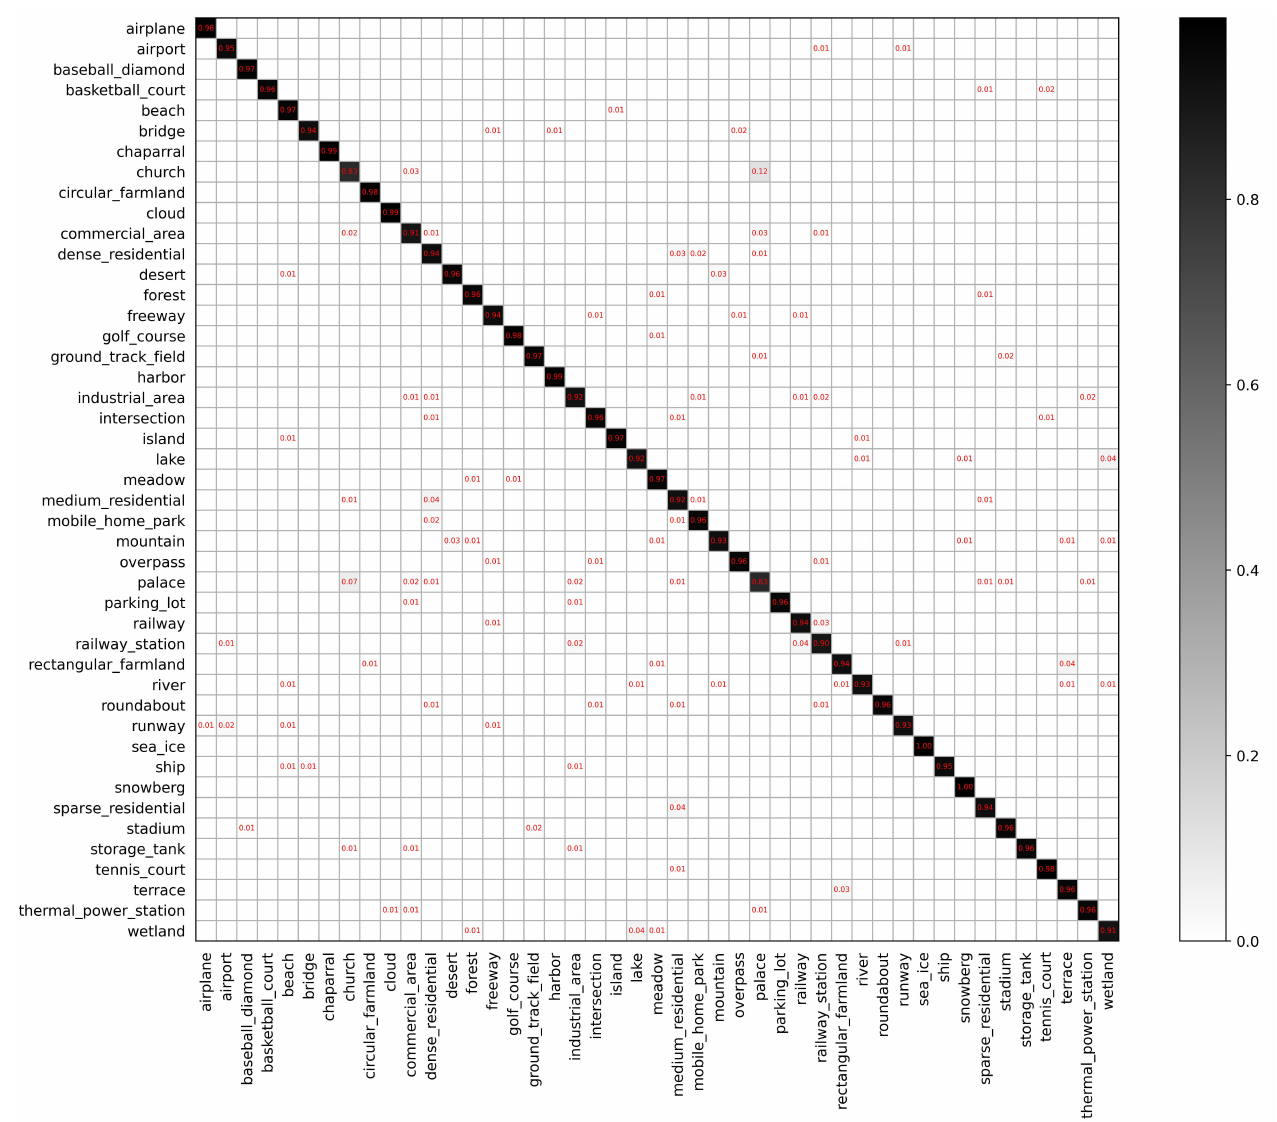
Figure 12. Confusion matrix of the proposed method on the NWPU-RESISC45 dataset with a training ratio of